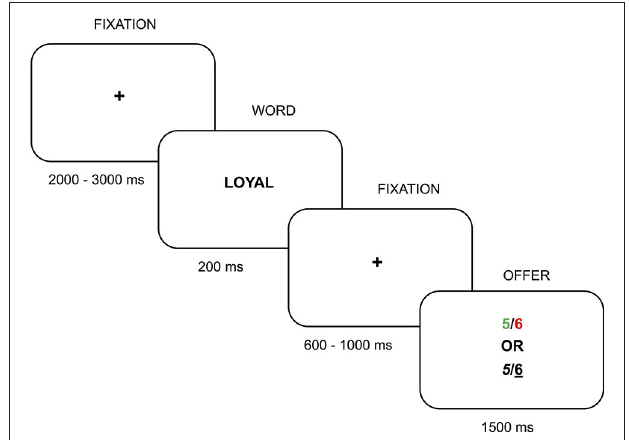
FIGURE 1 | Schematic display of a trial